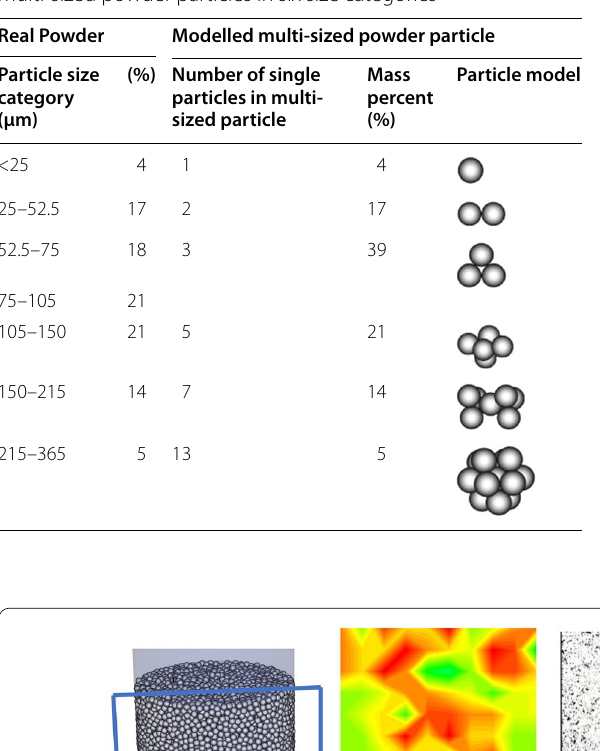
Table 3 Particle size distribution of real powder and modelled multi-sized powder particles in six size categories